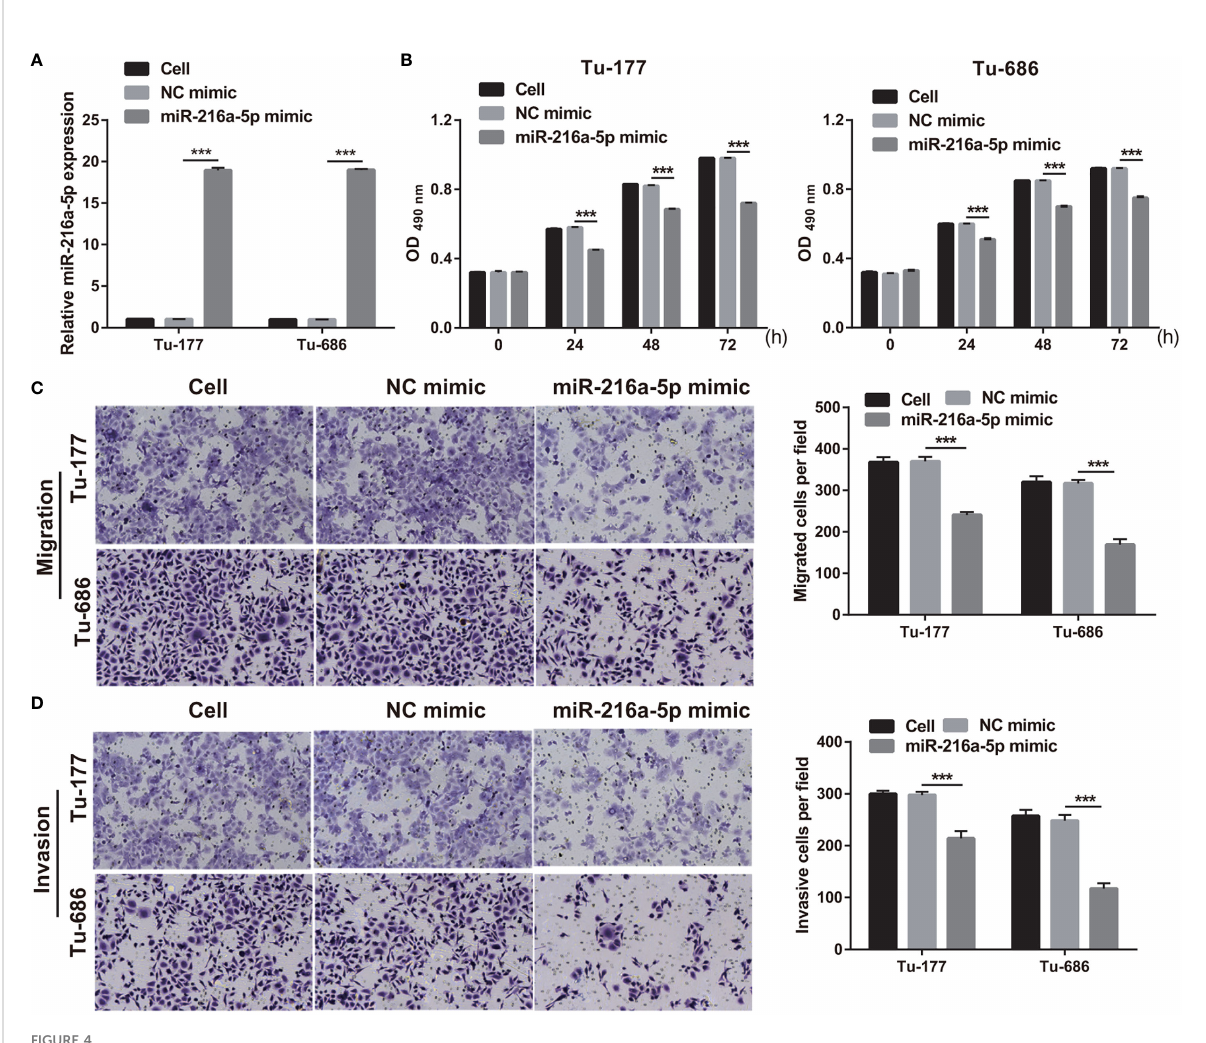
FIGURE 4 Overexpressionof miR-216a-5psuppressedLSCCbiologicalbehaviors. (A) miR-216a-5pexpression inTu-177andTu-686aftertransfectionwas quanti fi ed. (B) Effect of overexpression miR-216a-5ponproliferationinTu-177andTu-686were determined by MTSassay. (C,D) Effectofoverexpression miR-216a-5pon themigrationandinvasioninTu-177 andTu-686 wereassessedbyTranswellassay(100×magni fi cation). n =3, ***p